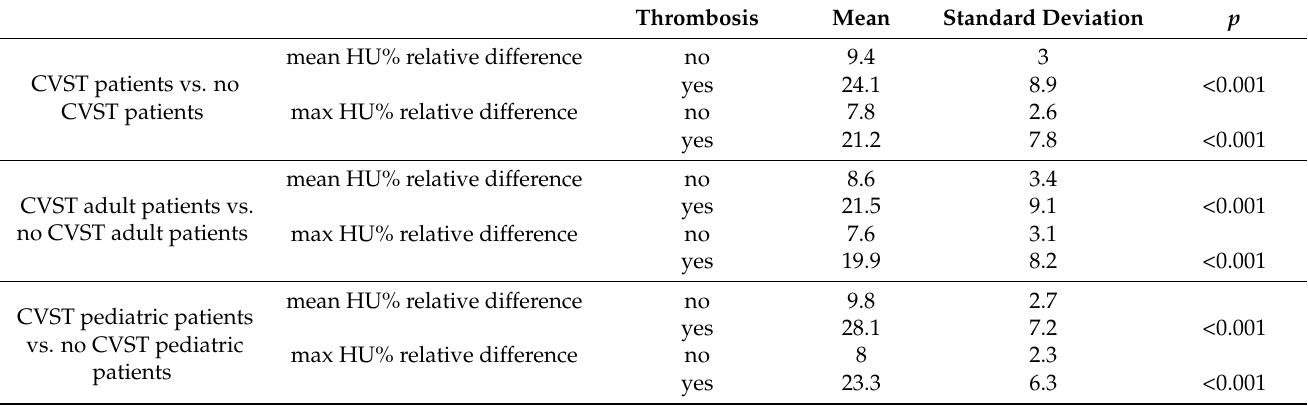
Figure 2. Box-plots showing the difference in Hounsfield Units (HU) mean percentual difference ( A , C , E ) and maximum percentual difference ( B , D , F ) respectively in all patients ( A , B ), adult ( C , D ) and pediatric ( E , F ) patients with and without thrombosis. Variation in patients with and without thrombosis; ( B ): box-plots showing the difference in HU maximum percentual variation in patients with and without thrombosis; ( C ): receiver operating characteristic (ROC) curve with cut-off for HU mean and HU maximum differences variations. Table 1. Results with mean Hounsfield unit percentage (HU%) and max HU% in patients with and without cerebral venous sinus thrombosis (CVST). The second and third rows show results in the adult and pediatric subgroups, respectively.